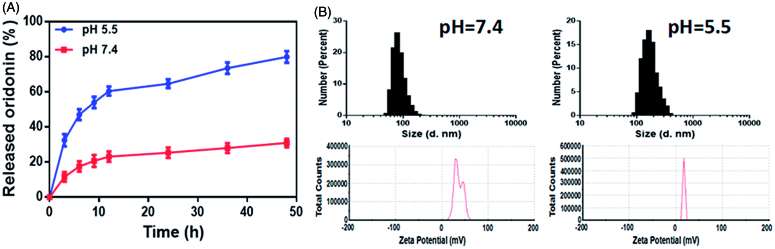
(A) In vitro release of oridonin from GE11-Ori-Se NPs at pH 5.5 and 7.4. (B) Size and zeta potential distribution of GE11-Ori-Se NPs in PBS solution (pH 5.5 and 7.4).